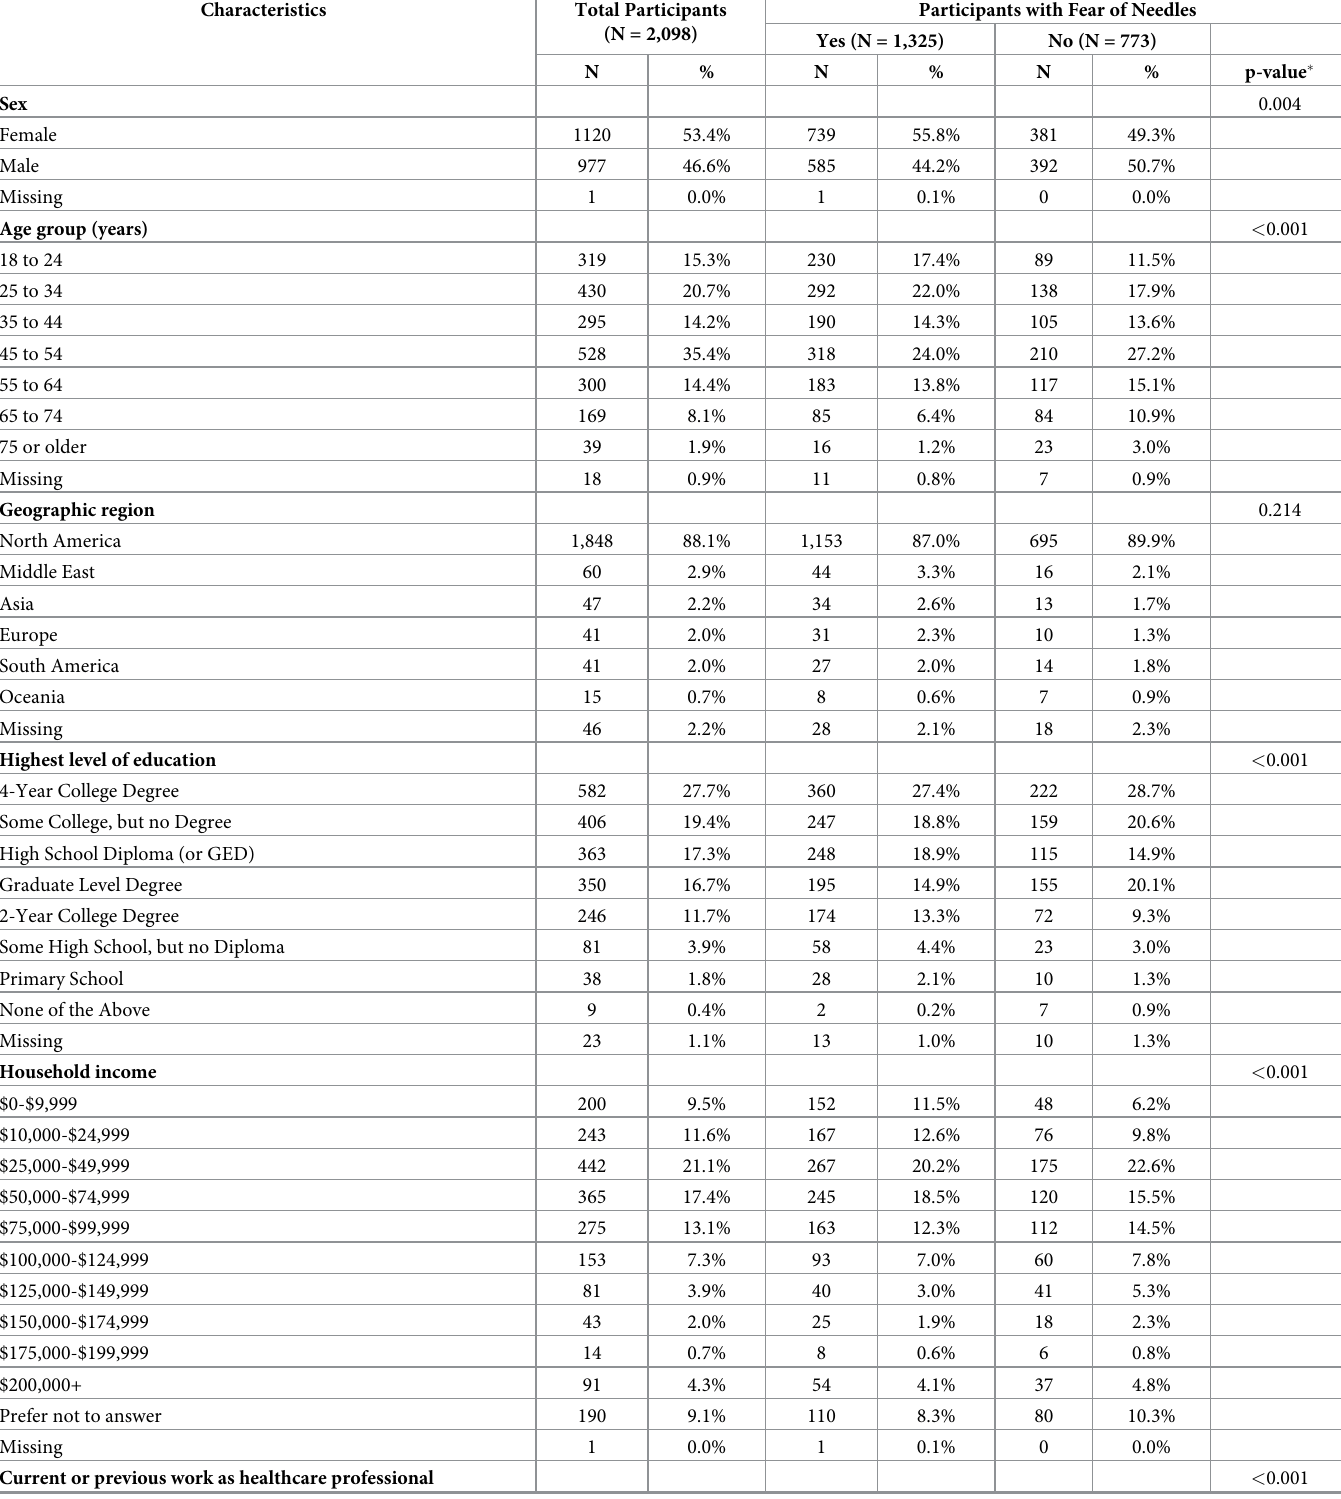
Table 1. Participant demographics and